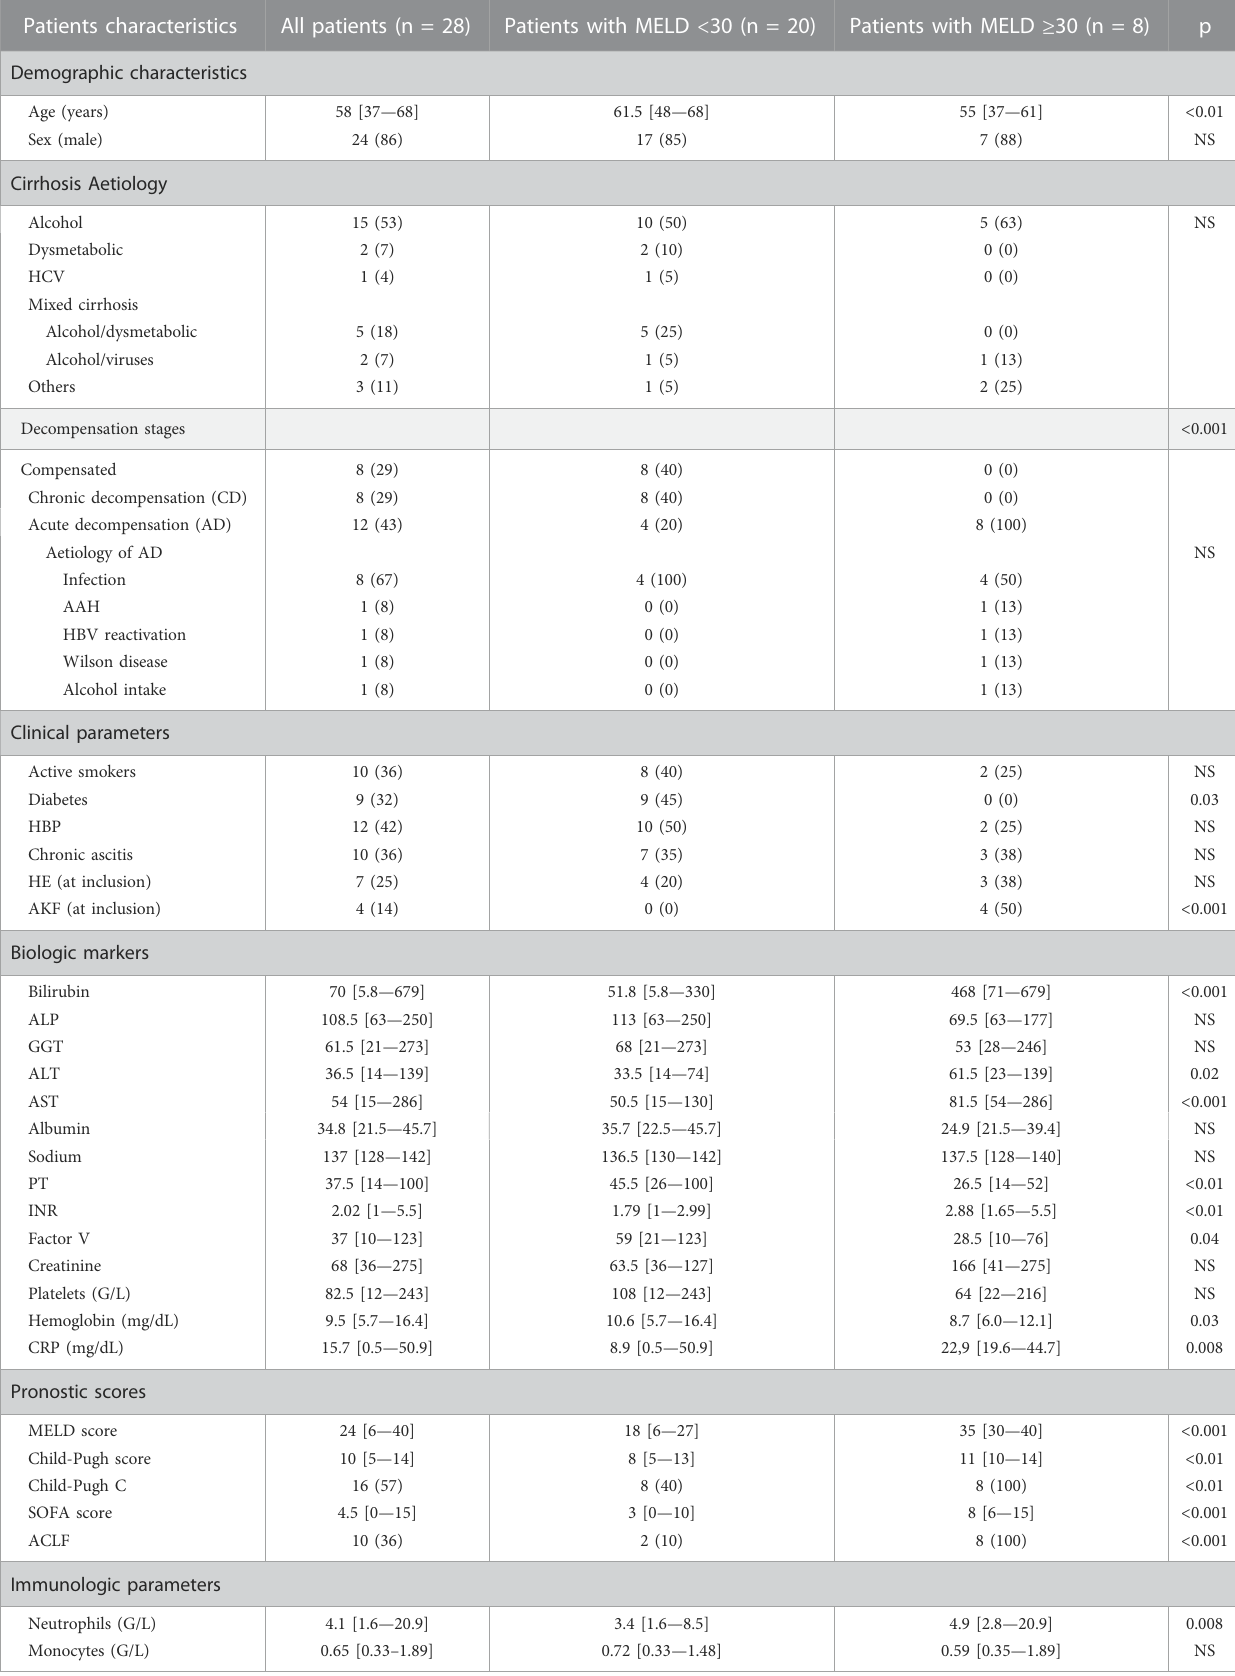
TABLE 1 Patients characteristics of whole cohort and according to MELD score. Patients